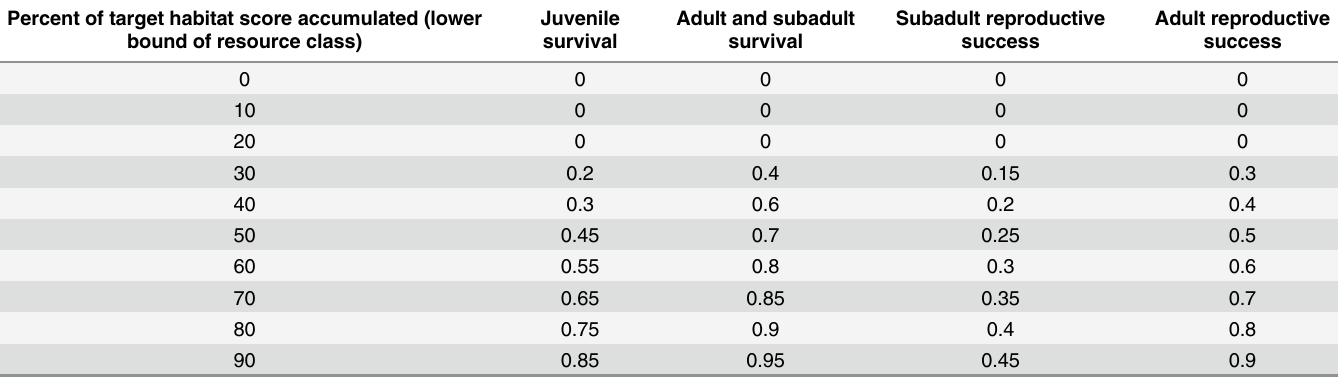
Table 1. Survival and reproductive success rates for modeled kit